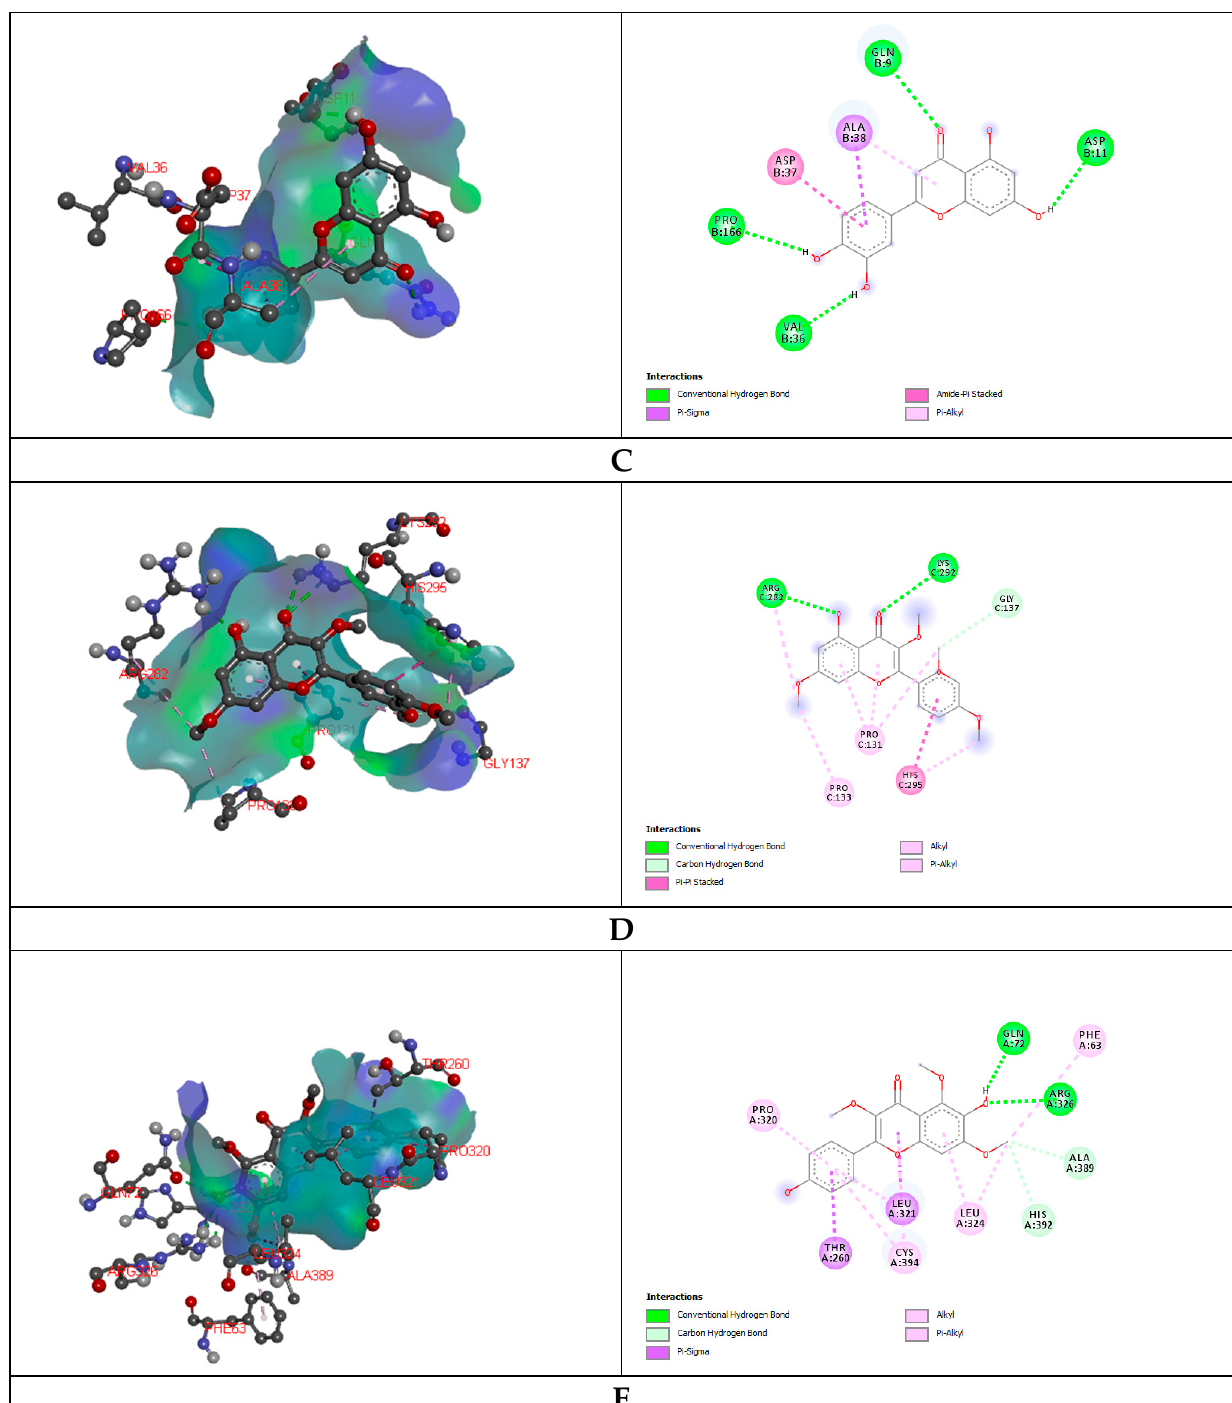
Figure 1. Representation (2D and 3D) docking results of best ranked pose of key interactions in the binding pocket of M3 muscarinic acetylcholine receptor (PDB ID: 5ZHP) with Galangin ( A ), human glutamate carboxypeptidase II (GCPII) with 6-Hydroxykaempferol ( B ), E.coli exonuclease I with Luteolin ( C ), GPCR beta arrestine with retusine ( D ), Cytochrome P450 14 alpha-sterol demethylase with 6-Hydroxykaempferol ( E ) respectively. against selected compounds to assess the antibacterial binding affinity of the Table 7. Docking score of 6-Hydroxykaempferol, Galangin, Irisflorentin, Luteolin, Retusine, and Loperamide with M3 muscarinic acetylcholine receptor (PDB ID: 5ZHP), human glutamate car- boxypeptidase II (PDB ID: 4P4D), Glutaminase domain (PDB ID: 1XFF), GPCR-Beta arrestin (PDB